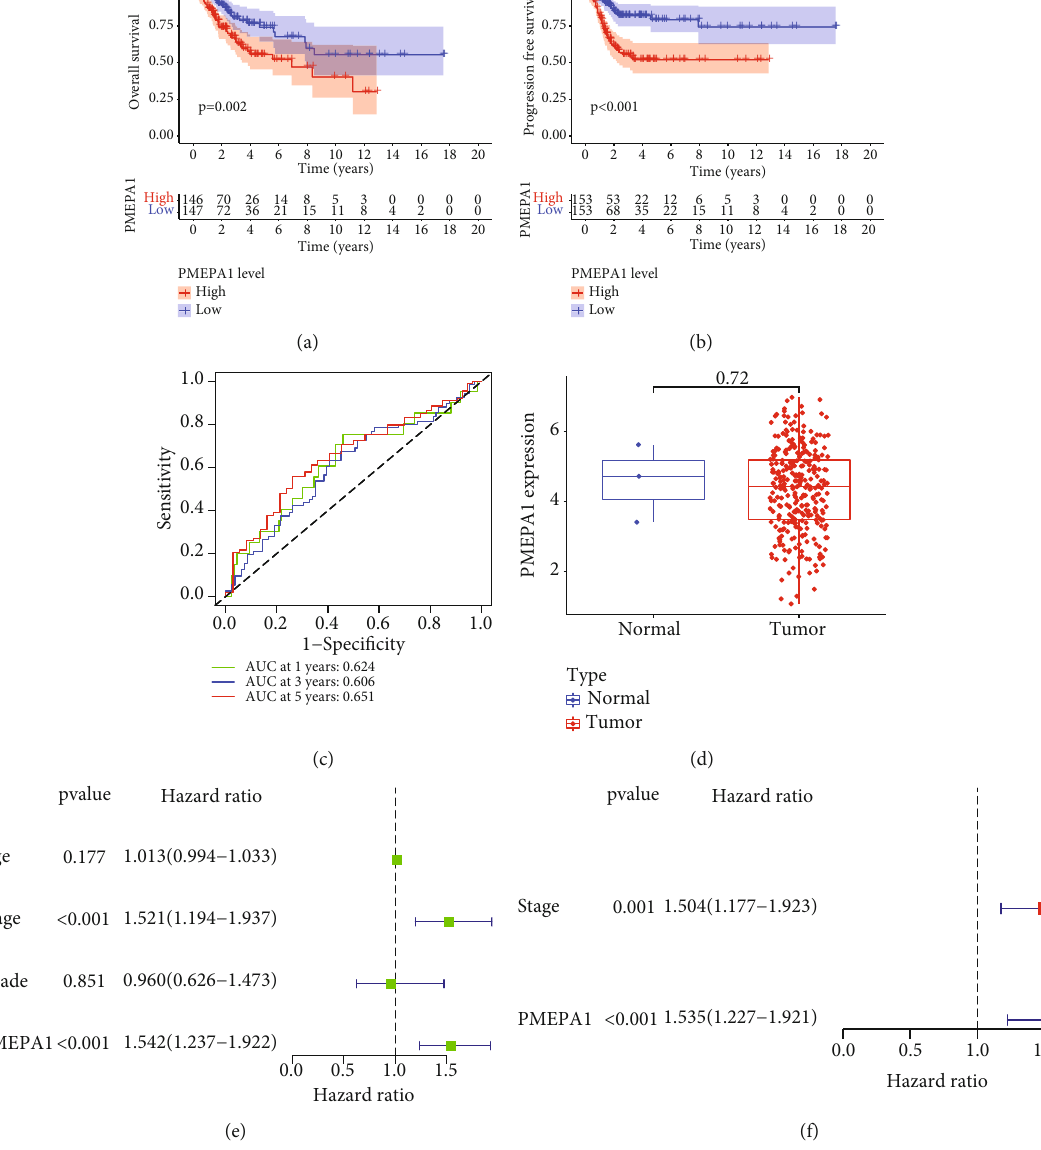
Figure 1: The prognostic value of PMEPA1 expression in CC. (a) K-M curves of OS in CC su ff erers. (b) K-M curves of progress-free survival in CC su ff erers. (c) Time-dependent ROC curves based on PMEPA1 expression. (d) The expression of PMEPA1 in 306 CC specimens and 3 normal cervical specimens from TCGA datasets. (e, f) The univariable and multivariable Cox regressive analysis of PMEPA1 expression and clinic characteristics regarding prognostic